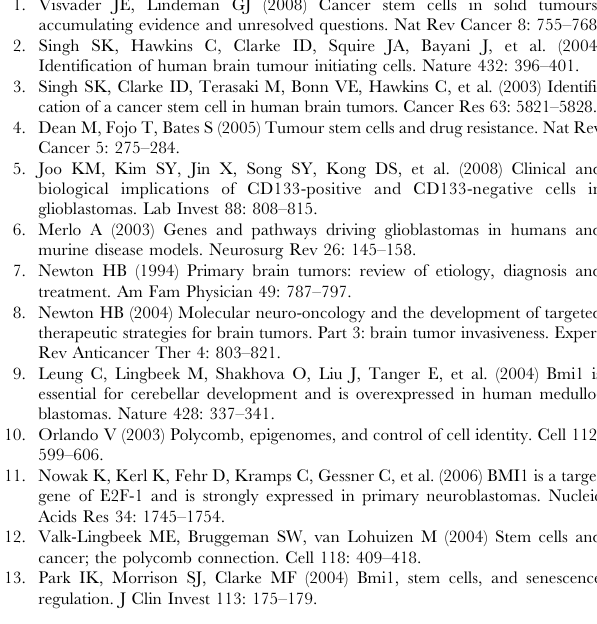
Figure S1 Bmi1 down-regulation reduces GSK3 b protein levels. (A) GBM cell line U87 is transduced with shRNA against Bmi1 (sh1061) or with scrambled shRNA (scr) (B) Bmi1 down regulation lead to GSK3 b reduction in Hs683 using a different shRNA sequence. (C) Bmi1 down-regulation in U87 glioma cell line